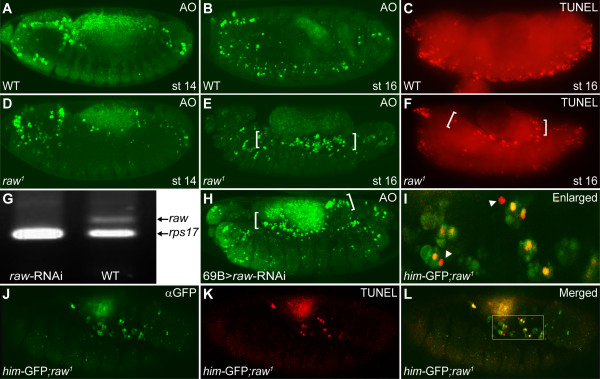
Down-regulation of raw causes cardial apoptosis. Epifluorescence micrographs showed localized cell death in the raw mutant. (A-C) Wild-type (WT) embryos, (D-F) raw1 mutant embryos. (A) Acridine orange (AO) positive cells were detected mainly in cephalic ganglia and head regions at stage 14. (D) raw1 mutant embryos of the same age displayed a similar AO staining pattern. Normal PCD detected using (B) AO or (C) TUNEL staining in wild-type embryos at stage 16. Excessive cell death (brackets) was observed in dorsal mesoderm of raw1 mutant embryos using (E) AO or (F) TUNEL staining. (G) Real time PCR quantification of raw mRNA level relatively to rps17 mRNA. (H) Knocking down the expression of raw in the ectoderm caused excessive cell death (brackets) in the dorsal mesoderm. (I-L) Double-labeling of dying cells using immunostaining of (J) him-GFP expressing cells (green) and (K) TUNEL (red) in raw1 mutant was assessed by confocol microscopy. (I) High magnification view of TUNEL and anti-GFP immunostained embryos from marked area (white box) in (L) merged image. Dying cells (yellow nuclei surrounded with green cytoplasma); Healthy him-GFP-positive cells (green); Unidentified dying cells (red, white arrowheads). WT, wild-type; st, stage.